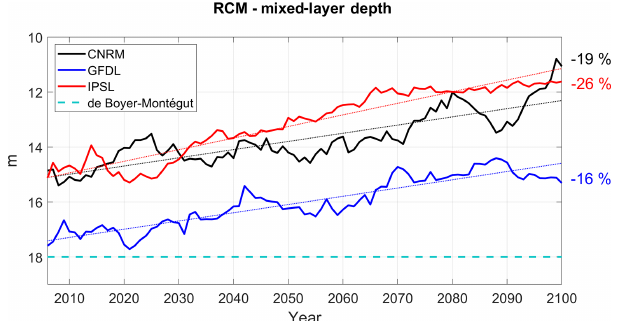
Figure 7. RCM mixed-layer depth (in meters) in the RCMs (CNRM in black, GFDL in blue, IPSL in red). Annual mean time series are filtered using a 10-year moving average. The climatological value derived from the De Boyer Montégut et al. (2004) climatology is marked by a dashed cyan line.